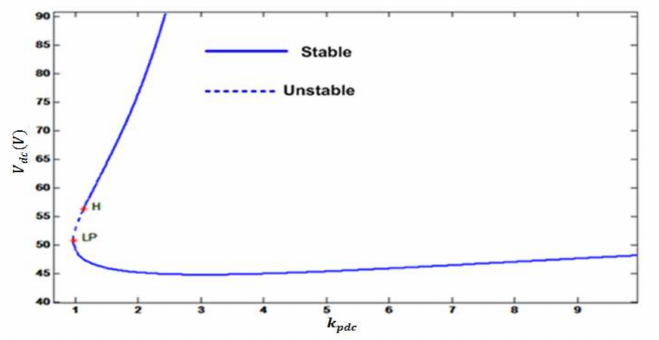
Figure 5. Bifurcation diagram in the plane ( k pdc , v dc ).